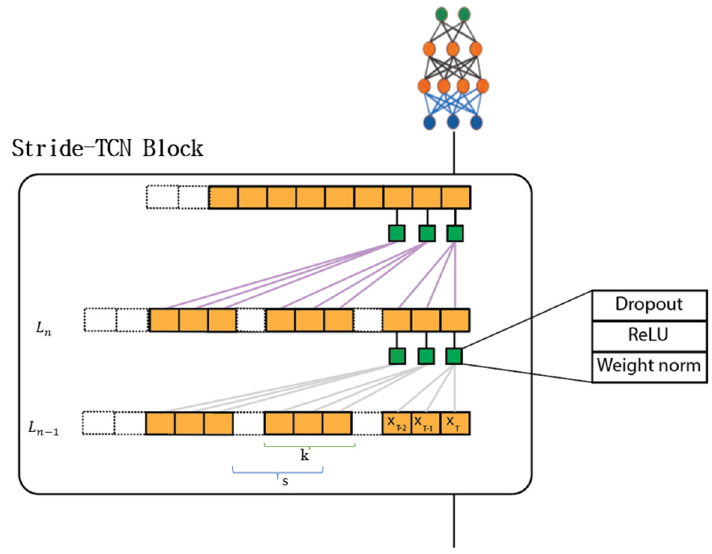
Figure 3. Stride-TCN architecture.